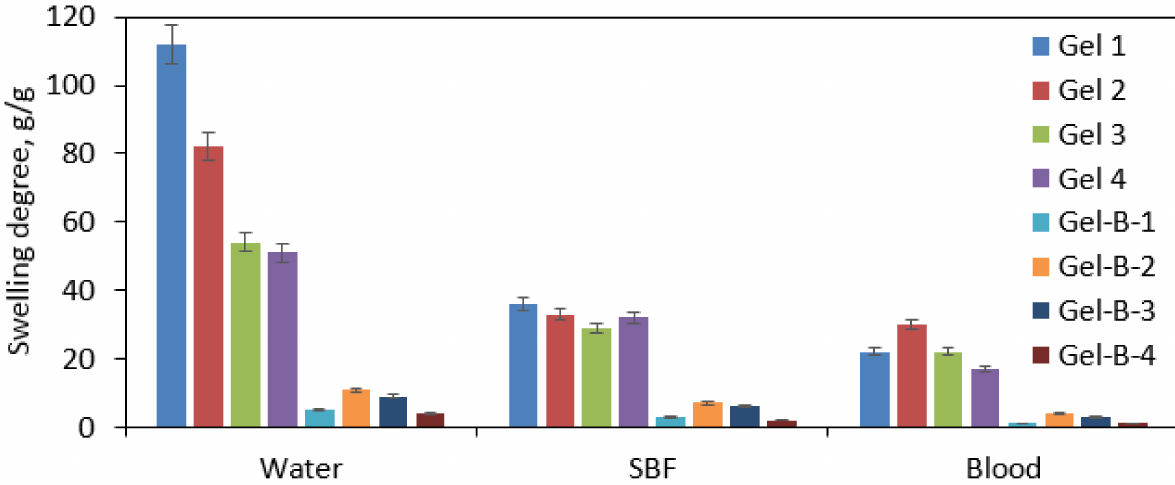
Figure 11. Swelling properties study in different swelling media (distilled water, simulated body fluid (SBF), and blood) of Gel 1–4 hemostatic agents in the form of a patch; Gel-B-1–4 hemostatic agents in the form of